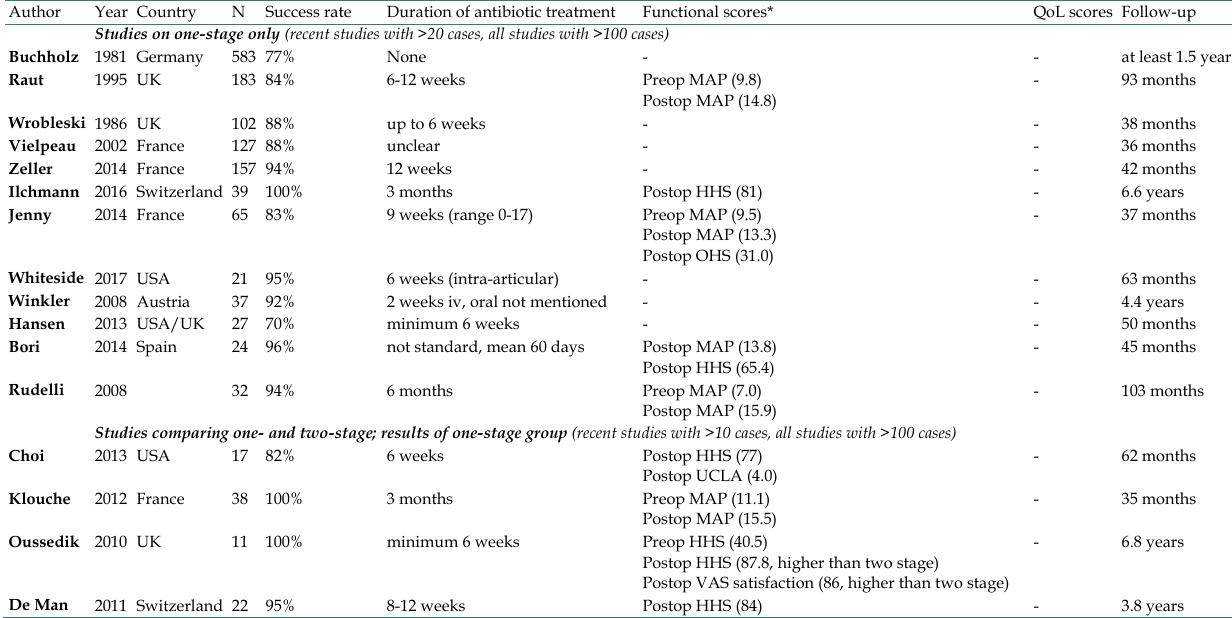
Table 4: Overview of studies on one-stage revision. Author